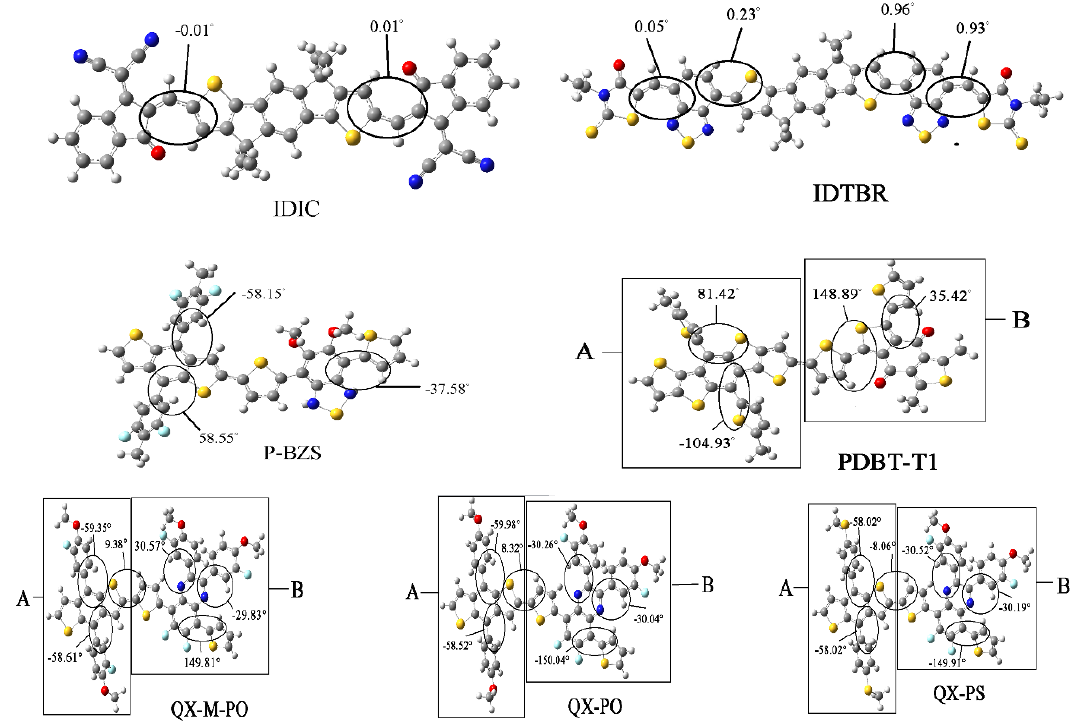
Figure 2. The optimized ground-state geometry structures, important dihedral angels, and definitions of molecular fragments of two NFAs, IDIC and IDTBR, and five kinds of polymers.